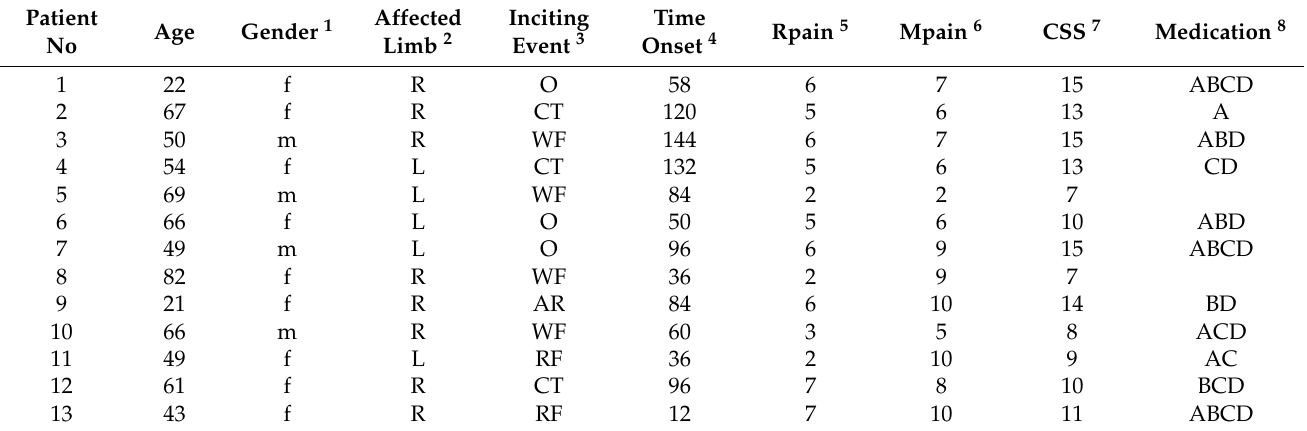
Table 1. Overview of demographic and clinical data of 13 CRPS